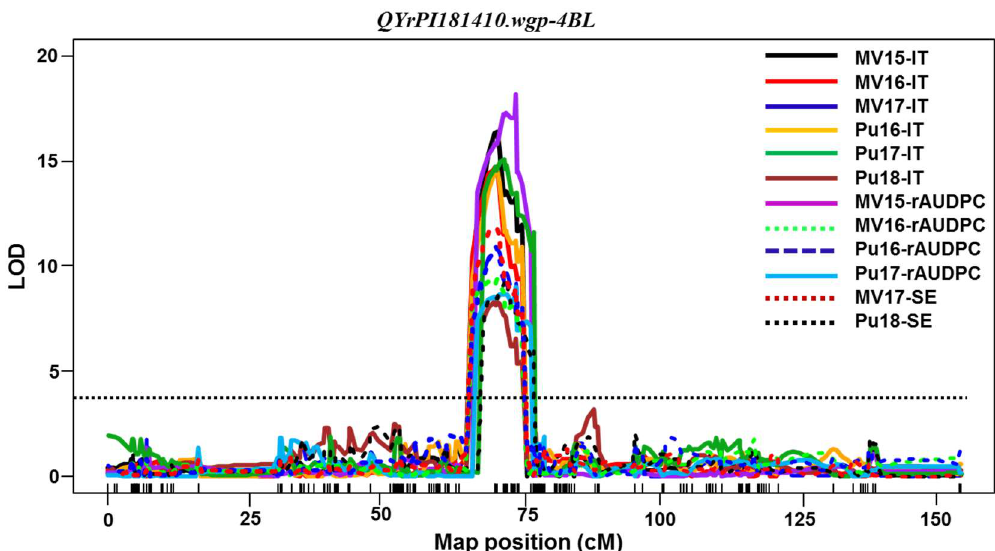
Figure 4. The LOD curves of QYrPI181410.wgp-4BL detected on chromosome 4B using 12 sets of data collected from the field tests across all environments including six sets of infection type (IT) data, four sets of relative area under the disease progress curve (rAUDPC) data, and two sets of disease severity (SE) data. The horizontal dotted line indicates the LOD threshold at 3.0.